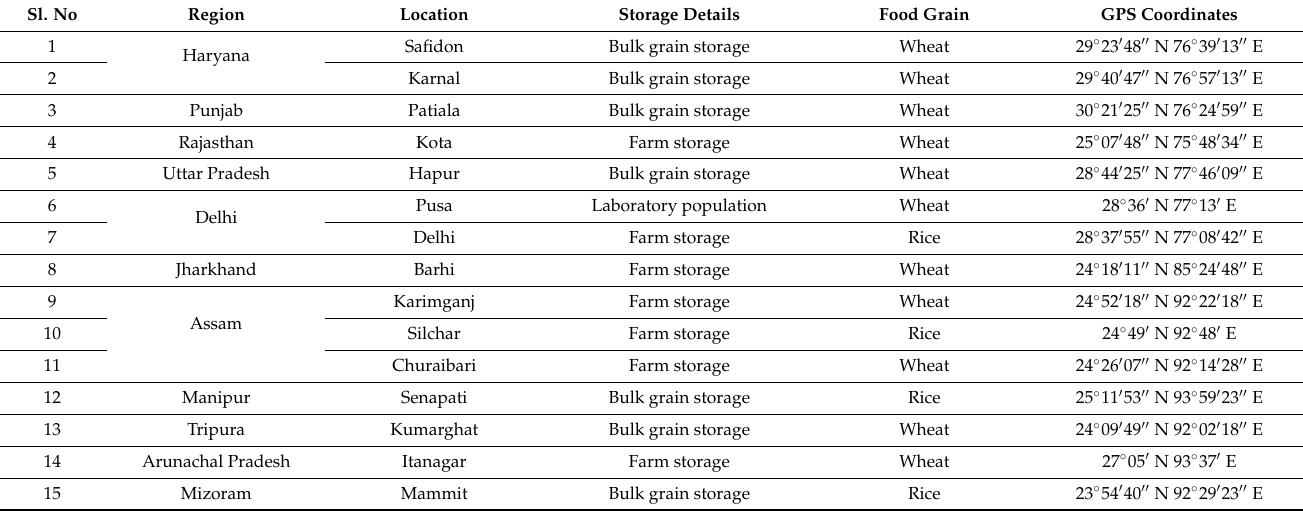
Table 1. Location details of Rhyzopertha dominica field